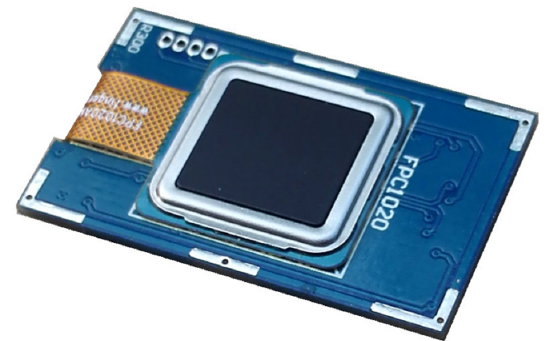
Figure 12. Fingerprint sensor (source: https://www.fingerprints.com).